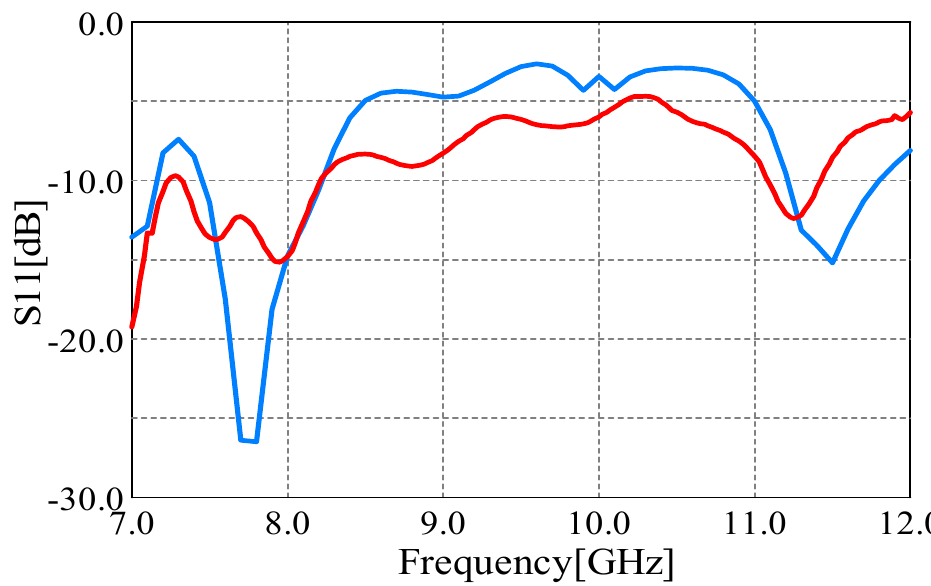
Figure 11. Simulation and measurement results for the reflection characteristics.